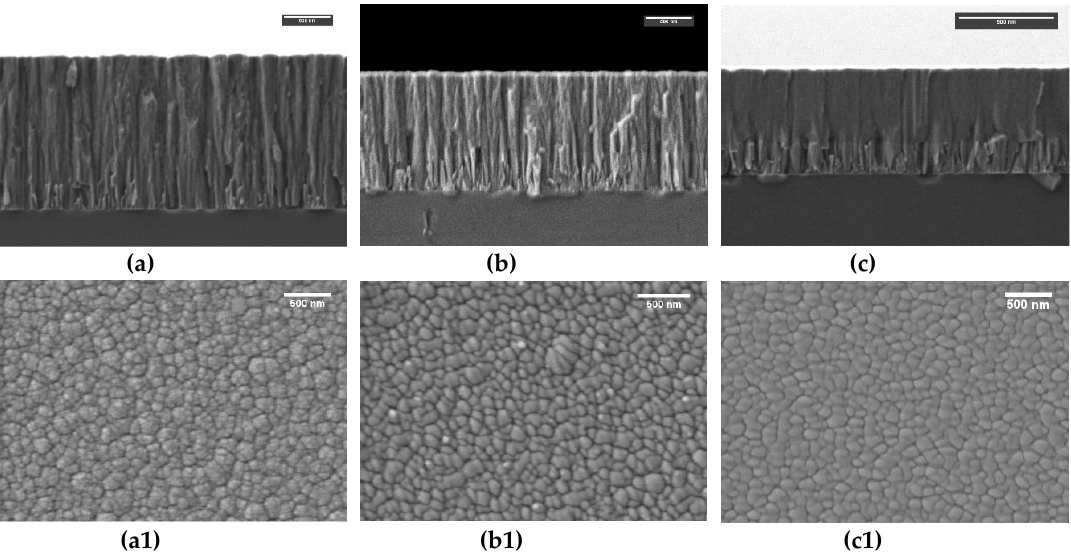
Figure 3. SEM images of the coatings cross section obtained by SEM ( a ) DCMS, ( b ) HIPIMS, ( c ) HIPIMS CH4, and surface morphology, ( a1 ), DCMS ( b1 ), HIPIMS ( c1 ) HIPIMS CH4.